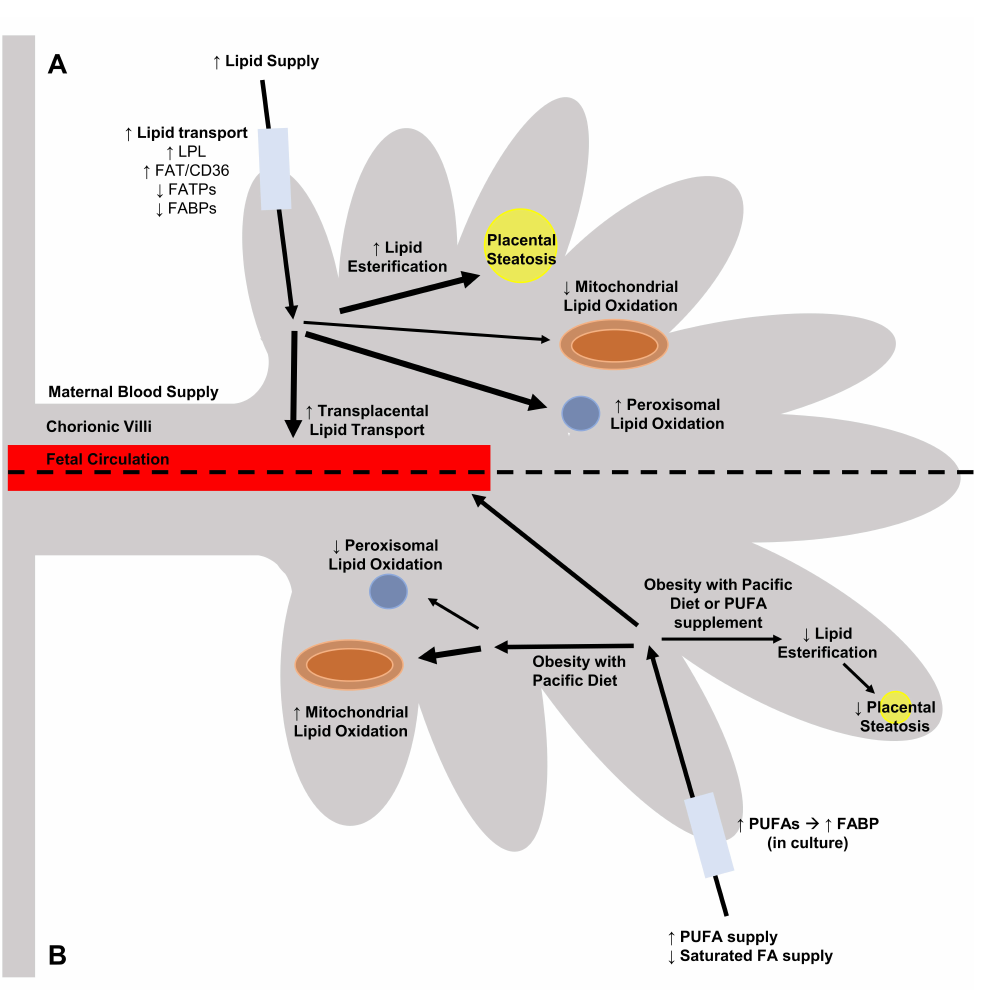
Figure 1. Summary description of alterations to the placental lipid processing functions of fatty acid (FA) transport, esterification and beta-oxidation under conditions of ( A ) maternal obesity and ( B ) with maternal diet improvement. Maternal gestational obesity has been associated with increased ( ↑ ) transplacental lipid transport (highlighted by increased expression of lipoprotein lipase (LPL) and fatty acid translocase (FAT / CD36) as well as decreased ( ↓ ) expression of fatty acid transport proteins (FATP) and fatty acid binding proteins (FABP)), increased placental lipid esterification and lipid